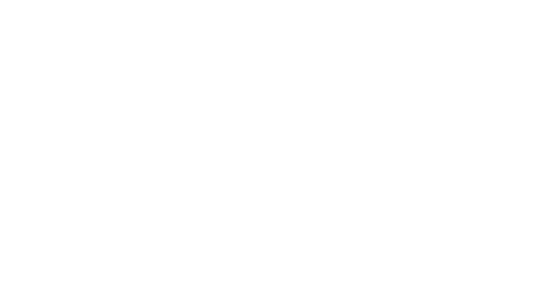
Table 3. Coefficients of the GLM model fitted to the full year rainfall occurrence data